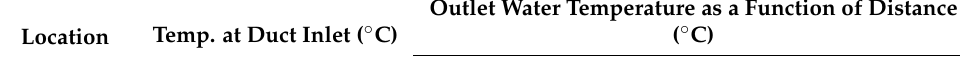
Table 6. Geothermal water temperature in a greenhouse depending on the distance from the intake.